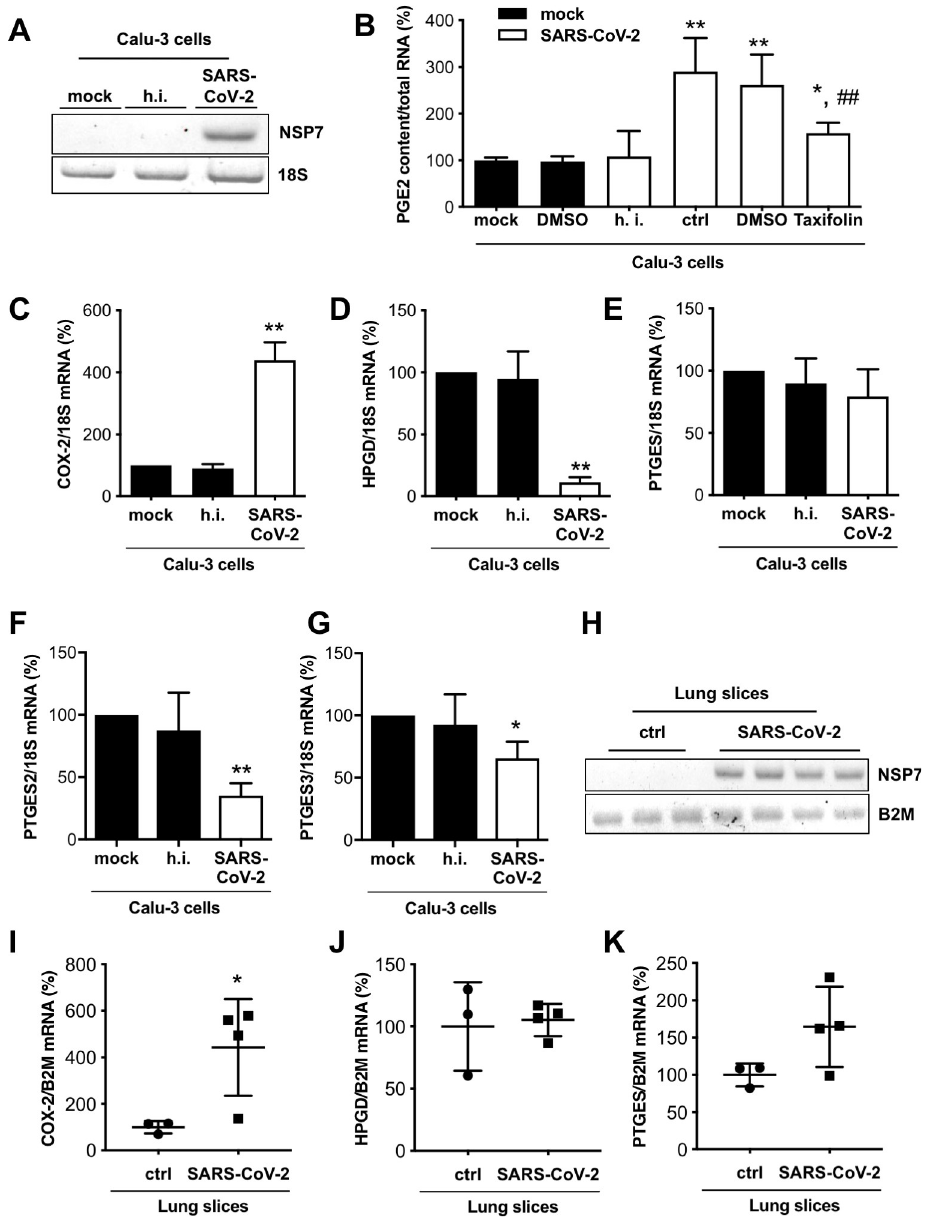
Fig 3. SARS-CoV-2 infection modulates PGE2 secretion and COX-2 and HPGD expression. (A) Representative gel image of NSP7 mRNA expression of Calu-3 cells infected with SARS-CoV-2 and control cells. (B) The bar graph summarizes PGE2 content in supernatants of Calu-3 cells infected with SARS-CoV-2 and treated with Taxifolin (n = 4) compared with untreated mock (n = 6), DMSO control (n = 8) and heat-inactivated (h.i.) SARS-CoV-2 (n = 6) normalized to total RNA. The bar graphs summarize mRNA expressions of (C) COX-2, (D) HPGD, (E) PTGES, (F) PTGES2 and (G) PTGES3 of SARS-CoV-2 infected Calu-3 cells (n = 3). (H) Representative gel image of NSP7 and B2M mRNA expression of SARS-CoV-2 infected lung slices (120 hpi) and control slices. The bar graphs summarize mRNA expressions of (I) COX-2, (J) HPGD and (K) PTGES of SARS-CoV-2 infected lung slices (120 hpi; n = 3 for ctrl, n = 4 for SARS-CoV-2 infection). Data are presented as mean ± SD, (B) unpaired two-tailed t -test, � P < 0.05 vs. mock, �� P < 0.01 vs. mock, ##P < 0.01 vs. SARS-CoV-2 + DMSO. (C-G) One sample t-test, � P < 0.05, �� P < 0.01 vs. ctrl, (I-K) unpaired two-tailed t -test, � P < 0.05 vs. ctrl. Underlying data can be found in S1 Data and uncropped gel images in S6